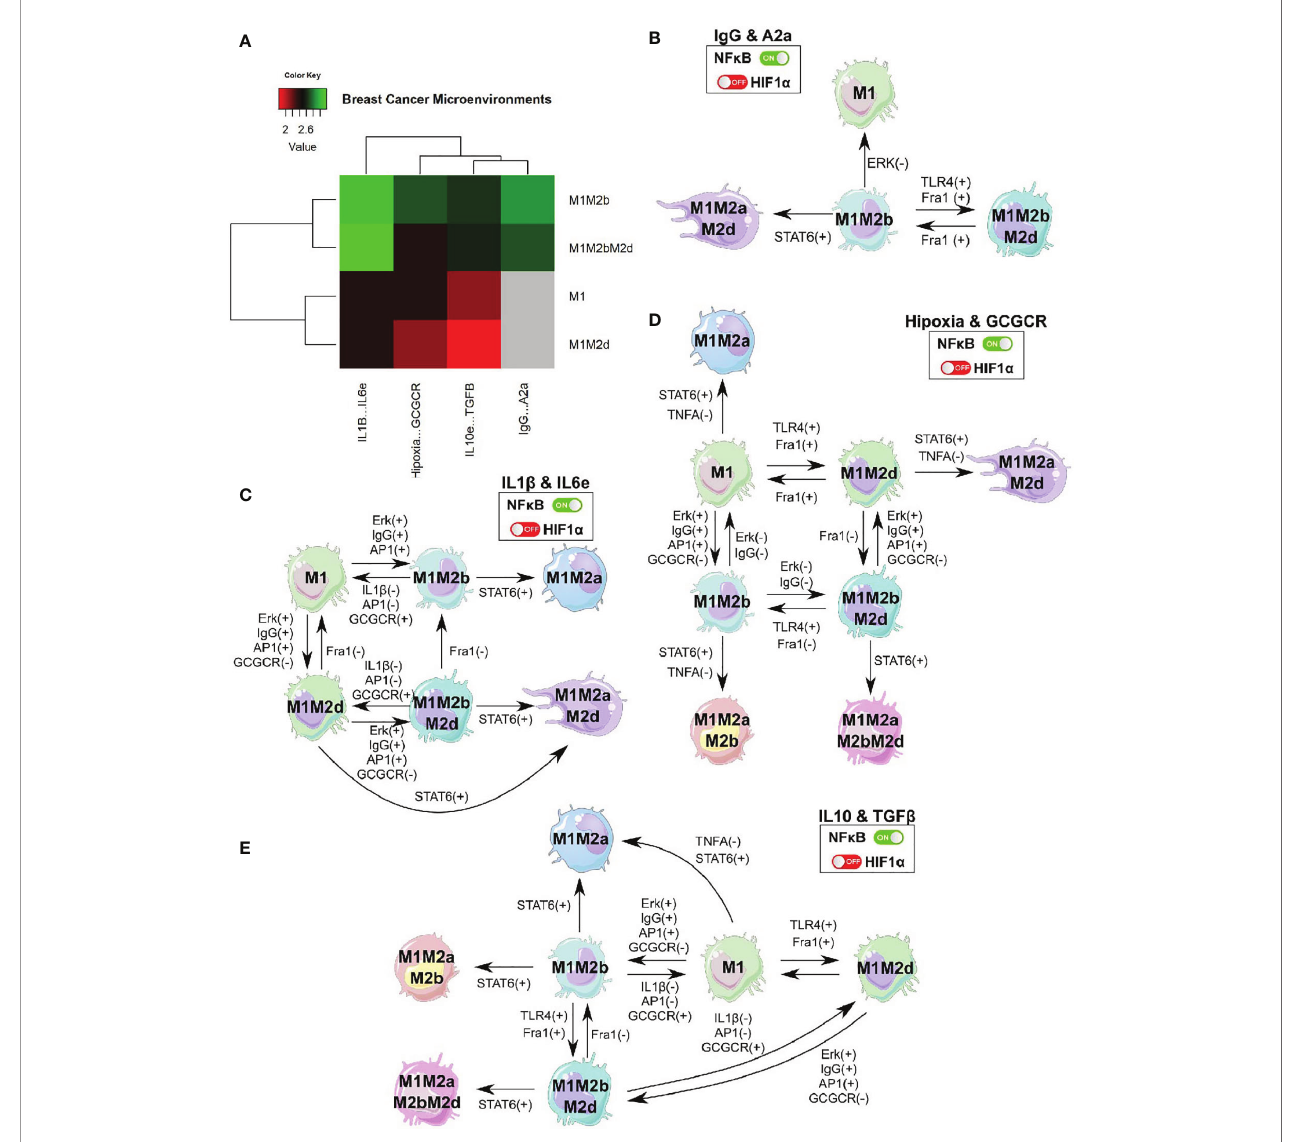
FIGURE 7 | TGEM in a breast cancer microenvironment. (A) We engineered different microenvironments associated with breast cancer and evaluate how our TGEM behaved. (B) Cell fate map of the theoretical genetically modi fi ed macrophage in breast cancer microenvironment for the expression of IgG and adenosines. (C) Cell fate map of the theoretical genetically modi fi ed macrophage in breast cancer microenvironment for the expression of IL1- b and IL-6. (D) Cell fate map of the theoretical genetically modi fi ed macrophage in breast cancer microenvironment for the expression of Hypoxia and glucocorticoids (GCGCR). (E) Cell fate map of the theoretical genetically modi fi ed macrophage in breast cancer microenvironment for the expression of IL-10 and TGF- b . This analysis was to evaluate the stability of our pharmaceutical approach in a breast cancer